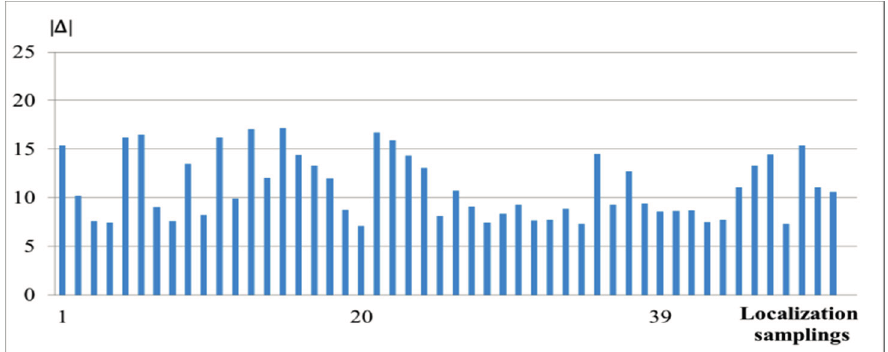
Figure 4. Percentage improvement of accuracy of the new scheme (4) over the reference scheme (1), | Δ |, based on 50 localization samplings in residential area in Hong